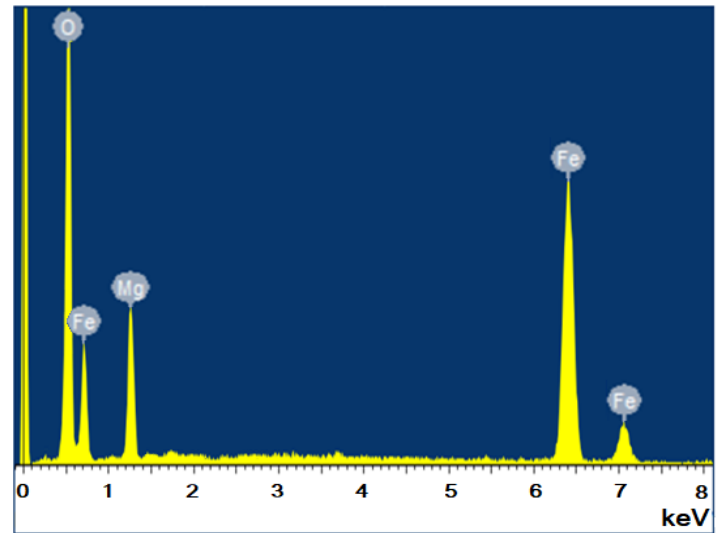
Figure 5. ED Х spectrum of MgFe 2 O 4 sample calcined at 1200 ° С . Figure 5. EDX spectrum of MgFe 2 O 4 sample calcined at 1200 ◦